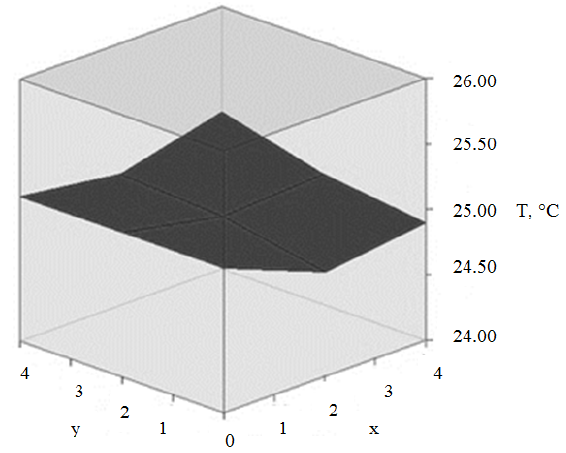
Figure 7. Graph of reservoir temperature distribution at a certain point in time.